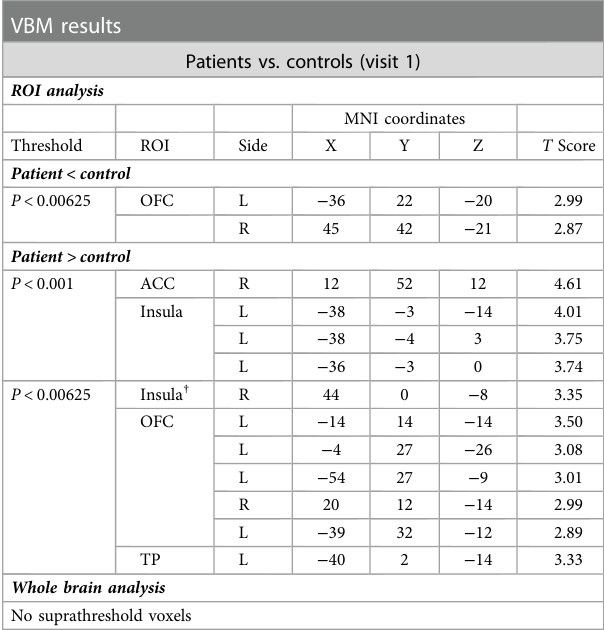
TABLE 3A Voxels of signi fi cant GM volume difference between patients and controls (visit 1).